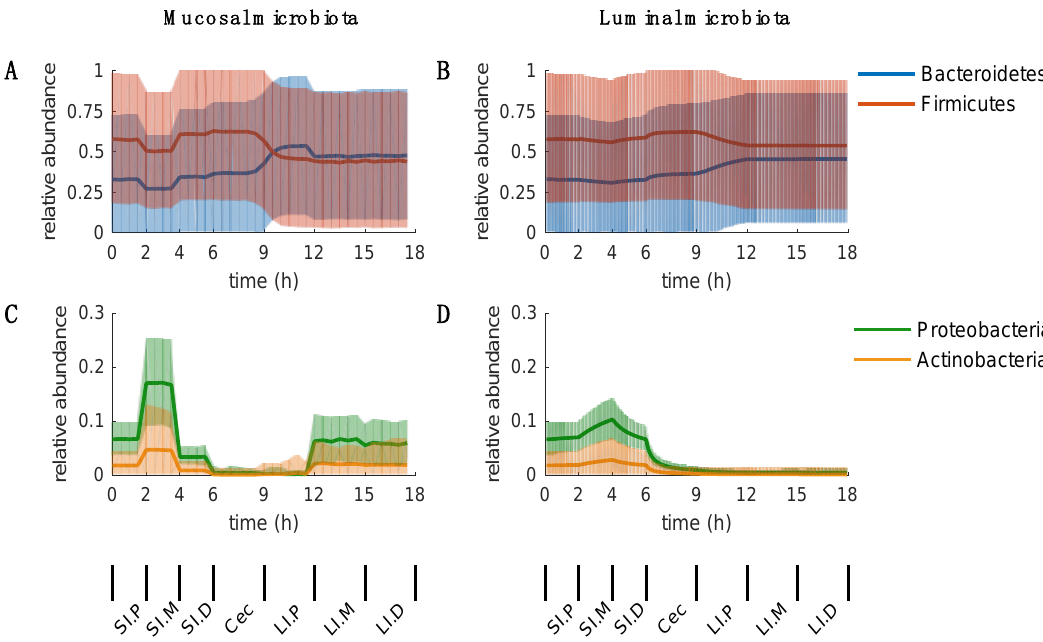
Figure 3. Simulated relative abundance profiles for the four phyla Bacteroidetes, Firmicutes, Actinobacteria and Proteobacteria in the gut community model. Relative abundances for Bacteroidetes and Firmicutes ( A ) on the mucus layer and ( B ) in the lumen. Relative abundances for Proteobacteria and Actinobacteria ( C ) on the mucus layer and ( D ) in the lumen. The shaded regions in all plots represent one standard deviation. The markers at the bottom show the time intervals for which simulations of the corresponding intestinal sections were performed. SI.P, SI.M and SI.D stand for proximal, middle and distal small intestine respectively. Cec stands for cecum. LI.P, LI.M and LI.D stand for proximal, middle and distal large intestine, respectively.